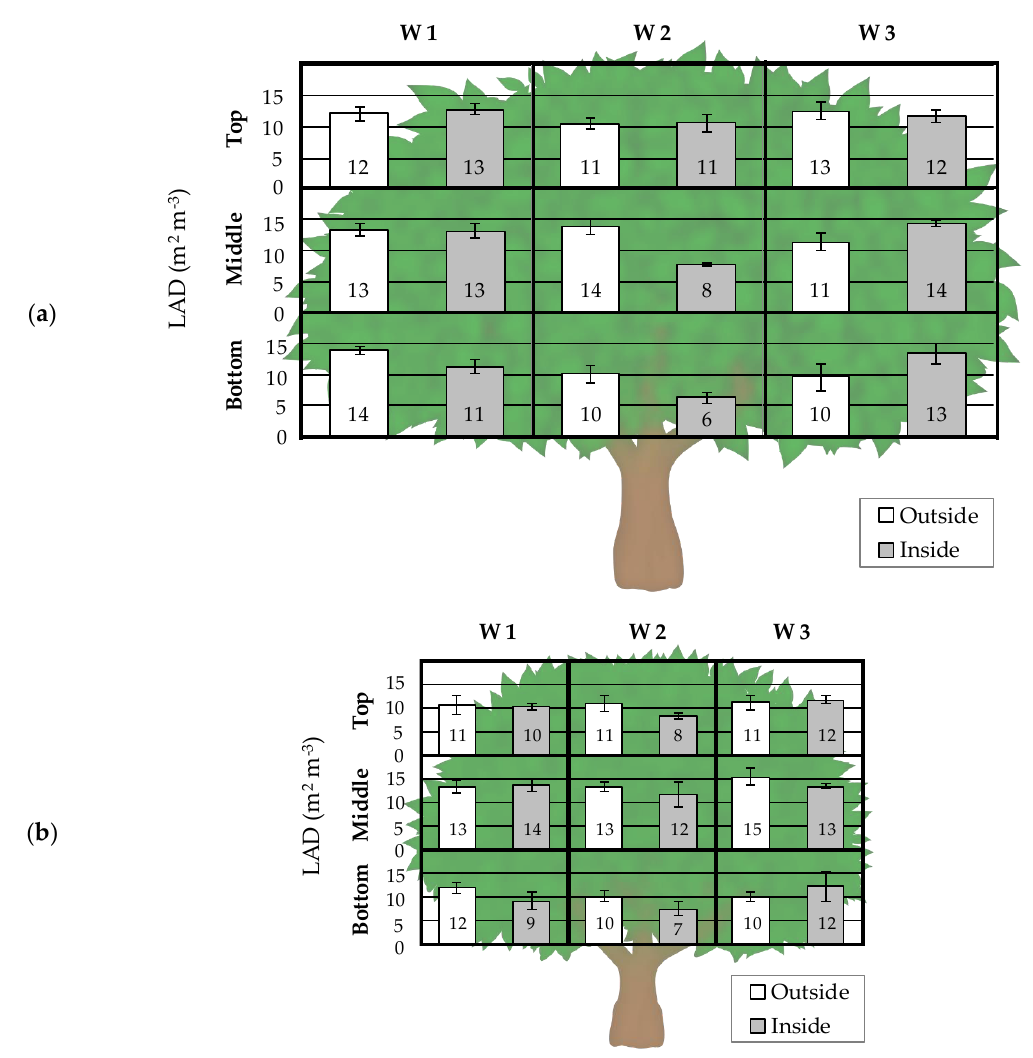
Figure 3. Leaf area density (LAD; calculated considering only one side of the leaves; mean (standard Figure3. Leafareadensity(LAD;calculatedconsideringonlyonesideoftheleaves; mean(standarderror error (s.e.)), m 2 of leaves m −3 of canopy) in the different canopy sections (combination of three (s.e.)), m 2 of leaves m − 3 of canopy) in the di ff erent canopy sections (combination of three heights, heights, three widths, and two depths) in ( a ) the adult plot and ( b ) the young plot. three widths, and two depths) in ( a ) the adult plot and ( b ) the young The highest LAD of the canopy was found in the outer part and middle height, while the lowest LAD was found in the interior area of Width 2, that is to say, the central zone of the canopy, especially at the bottom, both in the adult plot and in the young plot (Figure 3). The mean LAD of the adult plot was 11.61 ± 0.52 m 2 of leaves m −3 of canopy and that of the young plot was 11.42 ± 0.48 m 2 of leaves m −3 of canopy.